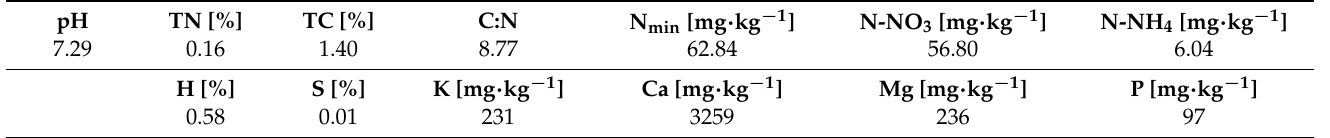
Table 2. Properties of soil used in the pot